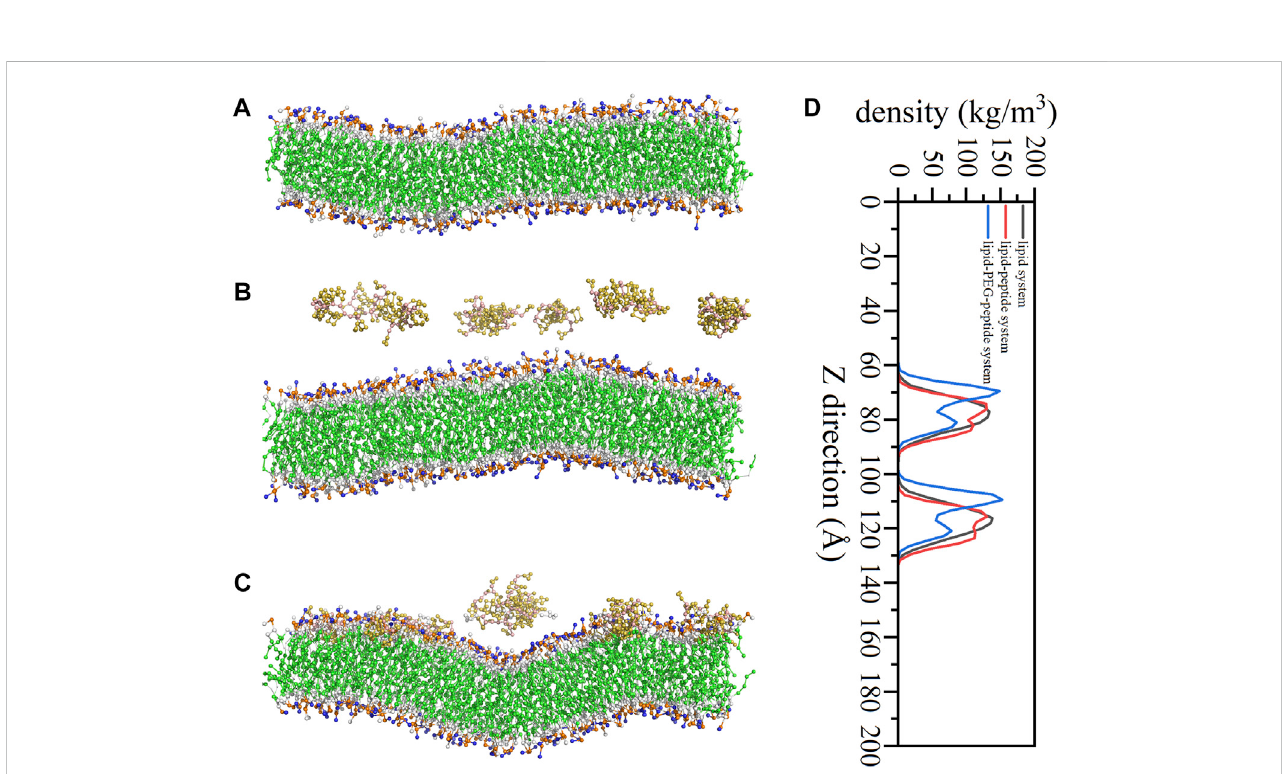
FIGURE 8 Snapshots of lipid system (A) , lipid-peptide system (B) and lipid-PEG-peptide system (C) at 2000 ns, for clarity, only peptides and lipid bilayers were shown; the concentrations of phosphate groups along the Z direction (D) .